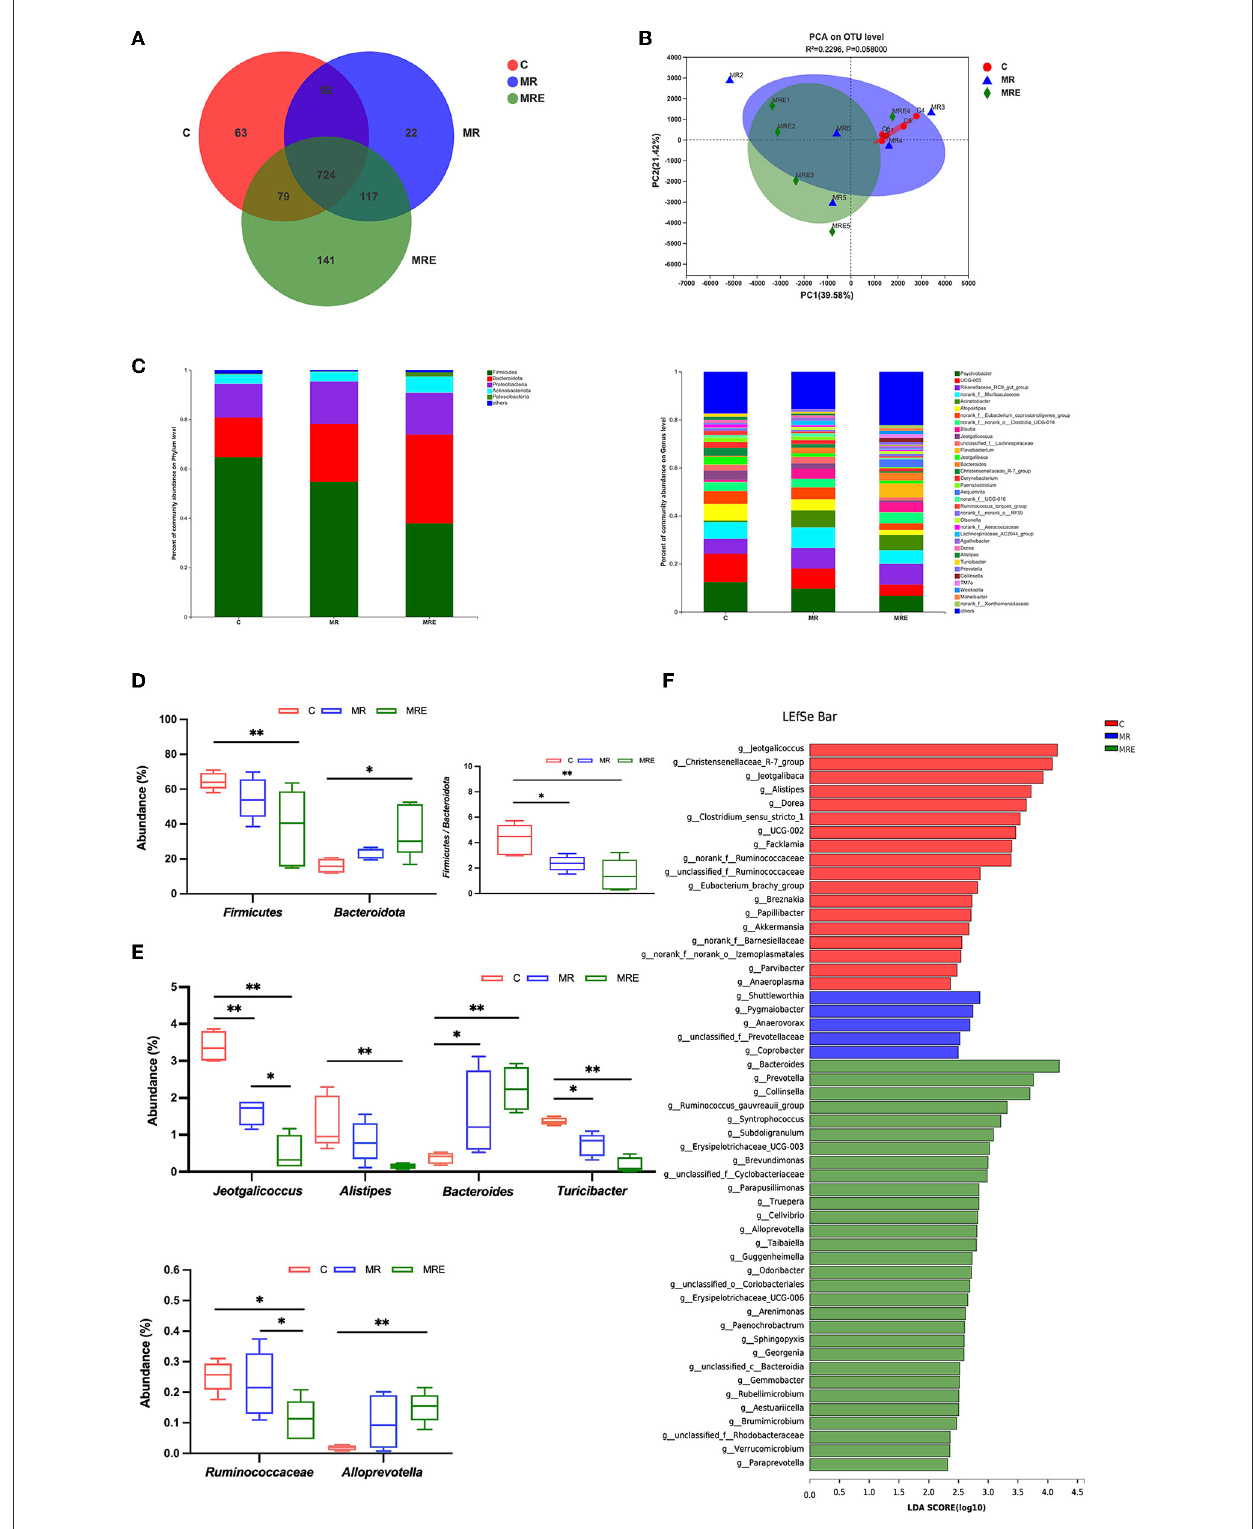
FIGURE3 Analysis of the diversity, composition, and taxonomic biomarkers of fecal microbiota. C, calves fed fresh milk; MR, calves fed milk replacer; MRE, calves fed milk replacer plus ethoxyquin. N = 5 in each group. (A) Venn diagram presenting the operational taxonomic units (OTUs) from each group. (B) β diversity shown in a Principal component analysis (PCA) scatterplot. (C) A bar graph of microbial composition at both the phylum and genus levels. (D) A box plot of the significant phylum among groups. (E) A box plot of the significant genera among groups. (F) Histogram of Linear discriminant analysis (LDA) scores representing the taxonomic biomarkers by LDA effect size (LEfSe) analysis. LDA score (log10) > 2 suggests the enriched taxa in cases. The data were analyzed by one-way ANOVA and Tukey’s test. * P < 0.05, ** P <